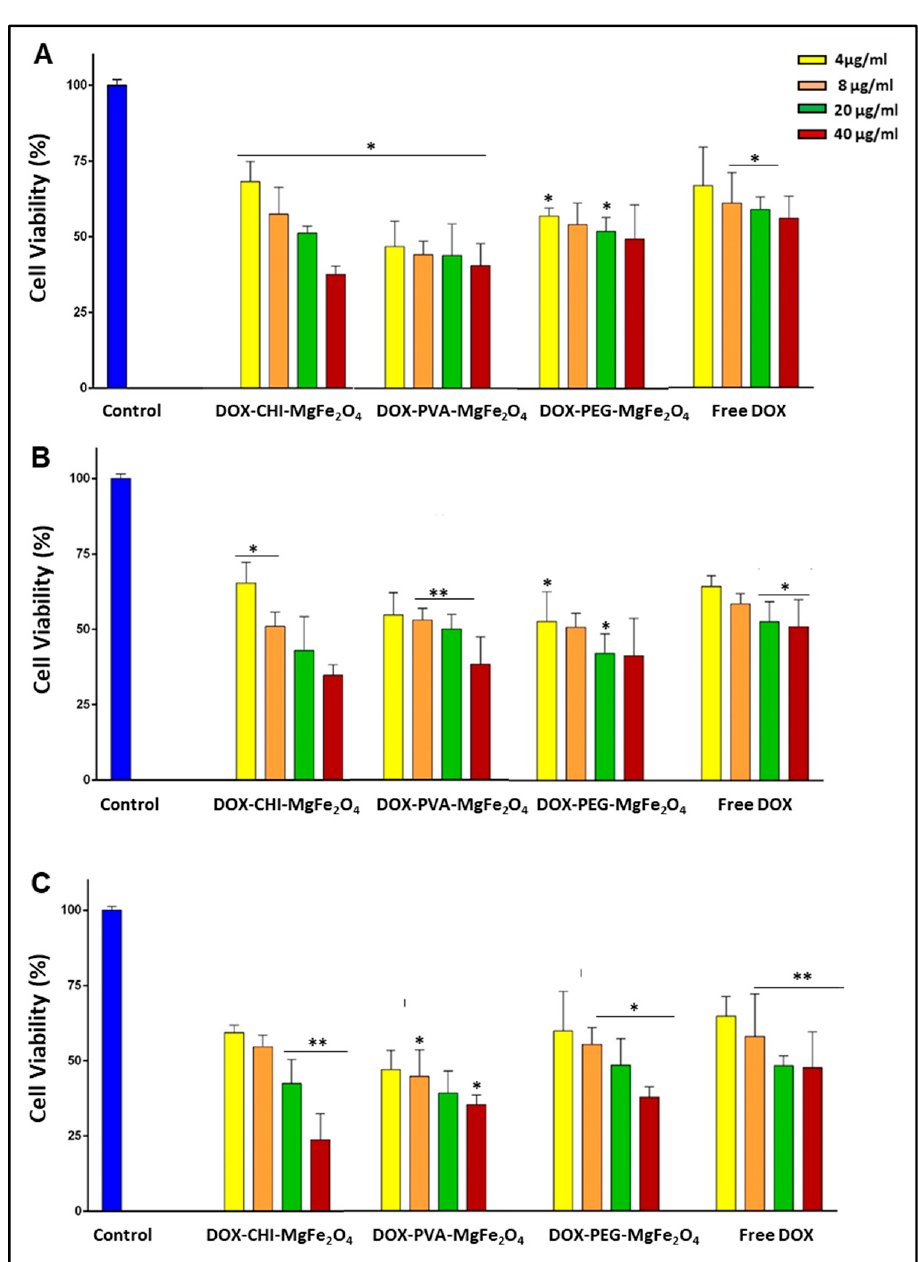
Figure 7. Cytotoxic profile for DOX-loaded MNPs and the free DOX in the ( A ) HEK293, ( B ) Caco-2 and ( C ) SKBR-3 cells. Data are represented as means ± SD ( n = 3), where * p < 0.05 and ** p < 0.01 are considered statistically significant. Table 6. Pseudo IC 50 ( µ g) values for DOX-loaded